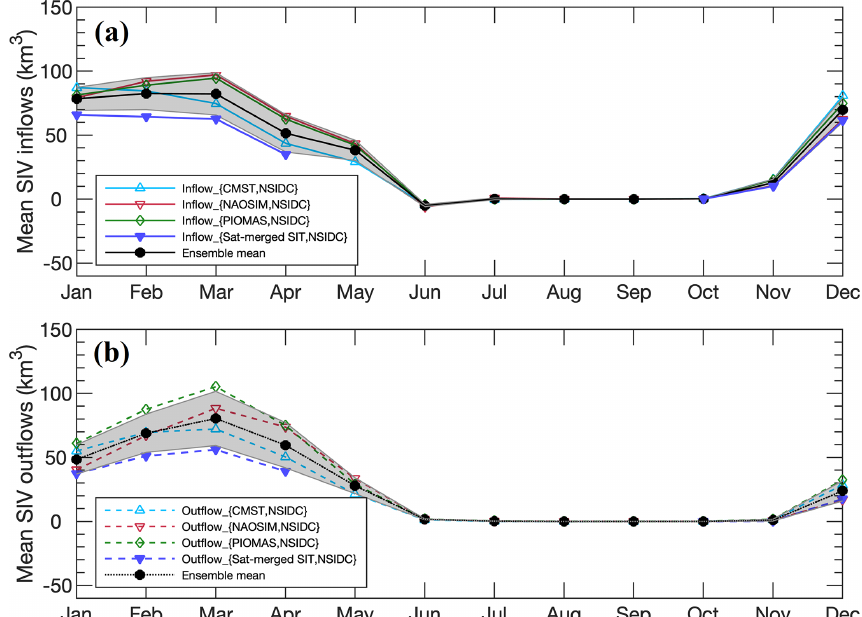
Figure 3. Averaged sea-ice volume (SIV) (a) inflows through the north gate and (b) outflows through the south gate between 2011 and 2016. The cyan lines are the fluxes derived from CMST SIT and NSIDC SID, the red lines indicate estimates from NAOSIM SIT and NSIDC SID, the green lines denote the fluxes from PIOMAS SIT and NSIDC SID, the blue line is for the fluxes from Sat-merged SIT and NSIDC SID, and the black lines represent the ensemble mean fluxes from the four inflows and outflows, respectively. Shaded areas indicate the standard deviation derived from the four different inflows and outflows,